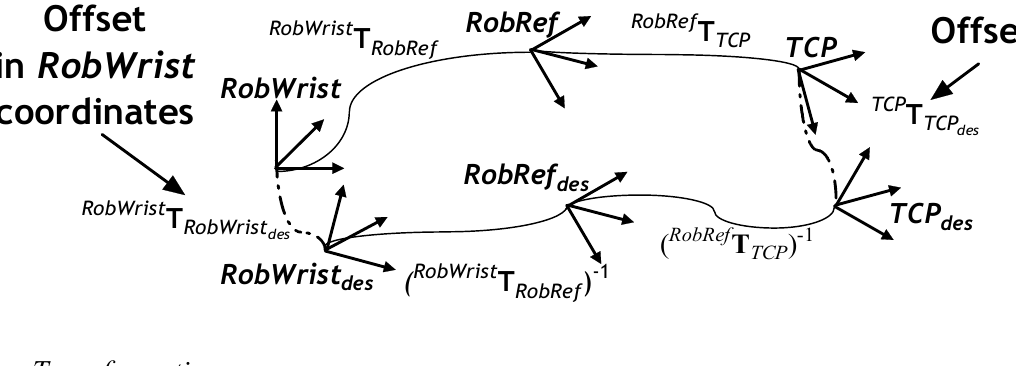
Figure 11. Offset transformation into RobWrist